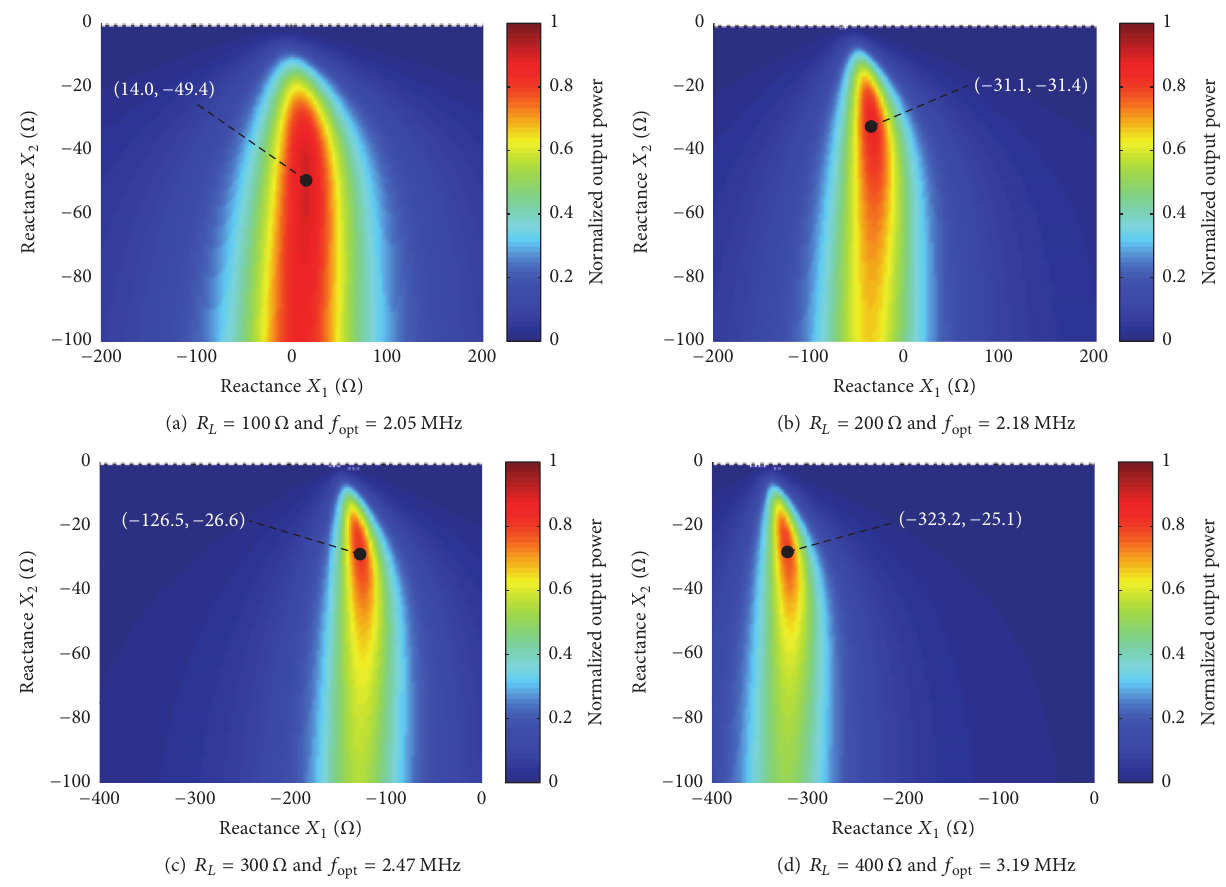
Figure 6: Calculated 𝑃 𝐿 versus 𝑋 1 and 𝑋 2 . The load reactance 𝑋 𝐿 = 0 Ω .